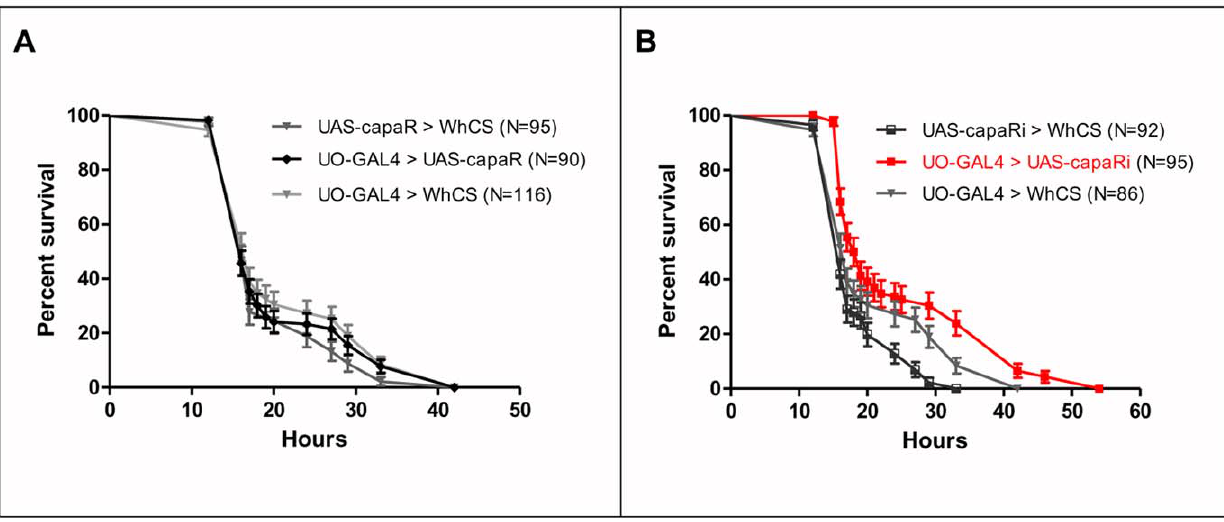
Figure 7. Knock-down of capaR expression in principal cells enhances organismal survival to desiccation stress. ( A ) Increased capaR levels in principal cells (UO-GAL4 . UAS-capaR, black line) do not alter survival of desiccated flies. ( B ) Reduced capaR levels in principal cells (UO- GAL4 . UAS-capaRi, red line) alter survival of desiccated flies. Desiccation resistance was significantly higher after knockdown of capa receptor in principal cells compared to controls (P , 0.001 against both controls; Log rank test, Mantel-Cox).